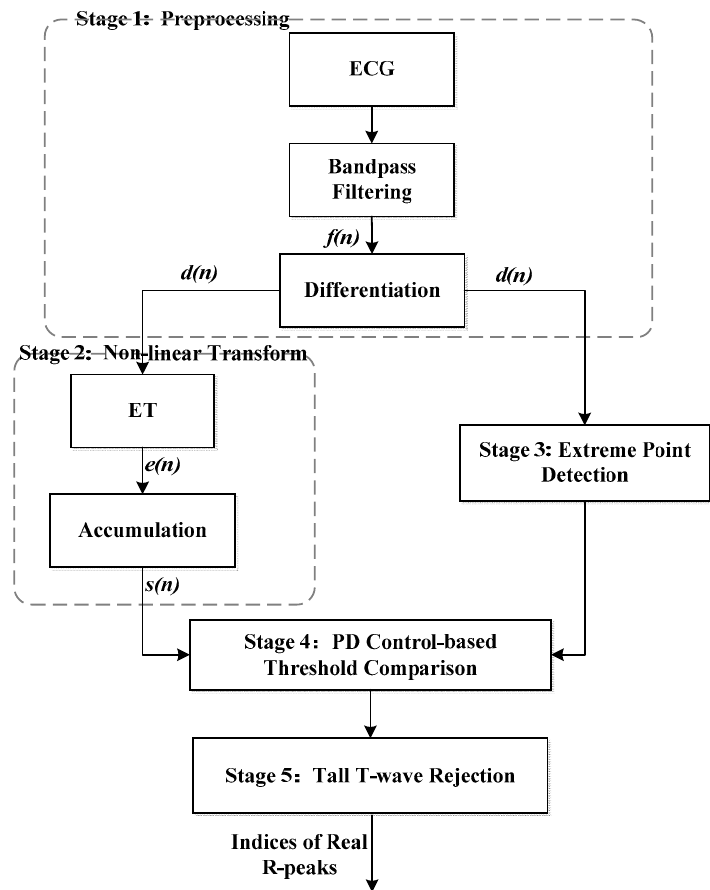
Figure 1. Block diagram of the proposed 5-stage algorithm for QRS-complex detection.